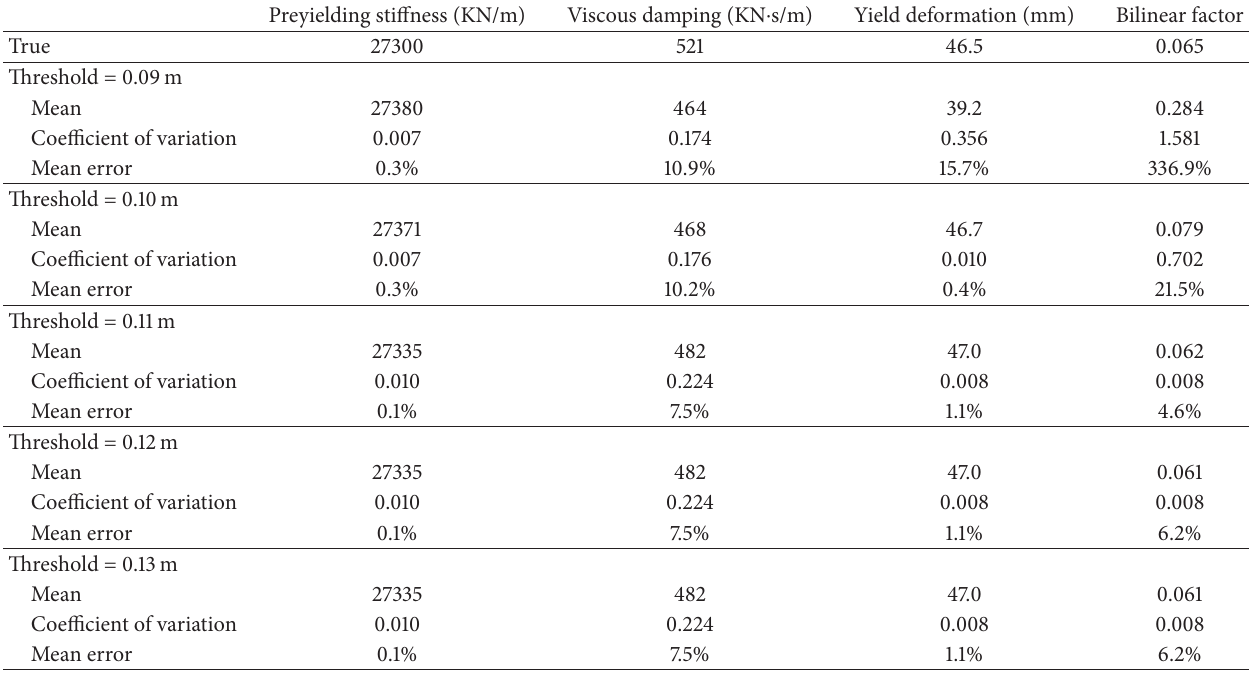
Table 4: Effect of threshold chosen on identification results.